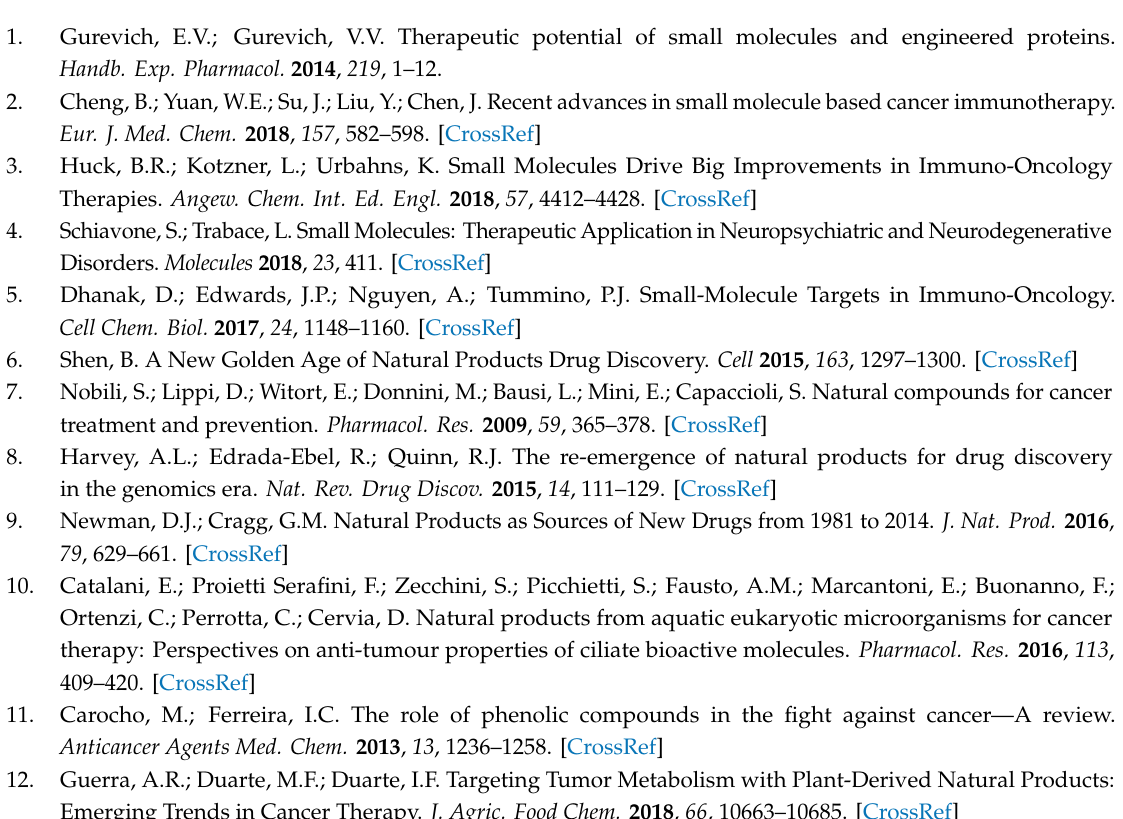
Figure S1: NMR spectroscopy (400 MHz, CDCl 3 ) and HRESIMS of compound 1, Figure S2: NMR spectroscopy (400 MHz, CDCl 3 ) and HRESIMS of compound 2, Figure S3: NMR spectroscopy (400 MHz, CDCl 3 ) and HRESIMS of compound 3, Figure S4: NMR spectroscopy (400 MHz, CDCl 3 ) and HRESIMS of compound 4, Figure S5: NMR spectroscopy (400 MHz, CDCl 3 ) and HRESIMS of compound 5, Figure S6: Western blot, Figure S7: Protein-ligand interactions fraction for evaluated ligands and X-linked inhibitor of apoptosis protein (XIAP) baculovirus IAP repeat (BIR)-3 domain during the molecular dynamics trajectory of 50 ns, Table S1: 1 H NMR (400 MHz) data for compounds 1–4 in CDCl 3 and compound 5 in MeOD, Table S2: 13 C NMR (100 MHz) data for compounds 1–4 in CDCl 3 and compound 5 in